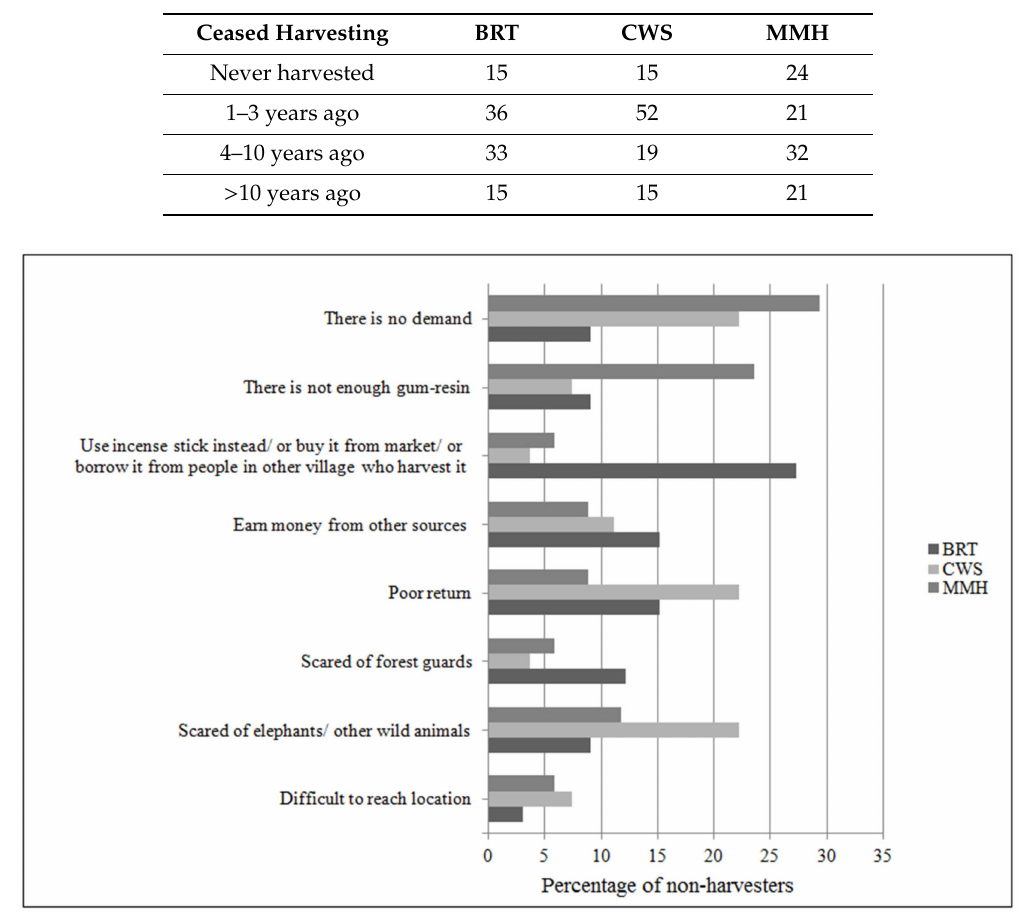
Figure 7. Reasons for not harvesting gum-resin and percentage of non-harvesters across the study